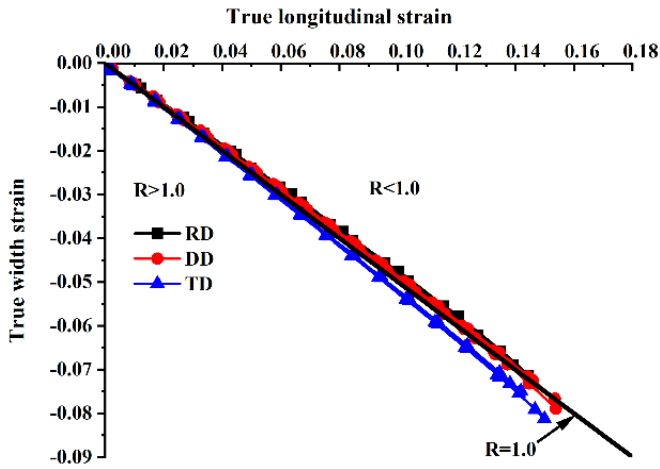
Figure 3. Anisotropy coefficients for the dog-bone specimens along different directions. By analytical calculation of the load-stroke curve along RD in Figure 2, the strain hardening curve before necking, where the elastic strain is removed from the total strain, is depicted in Figure 4. The maximum plastic strain before necking is approximately 0.17. The strain hardening curve is fitted by the Swift and Voce hardening laws as Equations (1)–(3) respectively, illustrating the hardening behavior with good consistency before necking. Nevertheless, the predicted results by using those two hardening laws are largely different after the necking strain. The Swift model predicts a higher loading capacity of the sheet metal than that obtained from the Voce model. Hence, the combined Swift-Voce model is used to modulate the predicted load capacity characterizing the strain hardening after necking. The parameters of the combined Swift-Voce model are shown in Table 3.